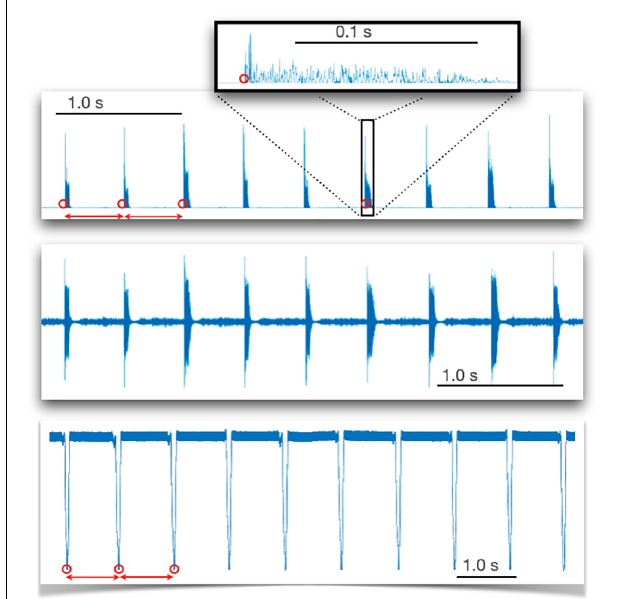
FIGURE 1 | Raw signals recorded with light detection (sampling rate 1 kHz) during circling (bottom panel) and sound detection (sampling rate 44.1 kHz) when cycling and finger tapping (tapping is shown as an example). For circling, interpeak time intervals are illustrated by red dots placed on successive peaks detected by a Matlab routine. For sound wave recordings (middle panel), the sound wave was squared (upper panel), then a threshold was detected unambiguously (inset) by a Matlab routine using a